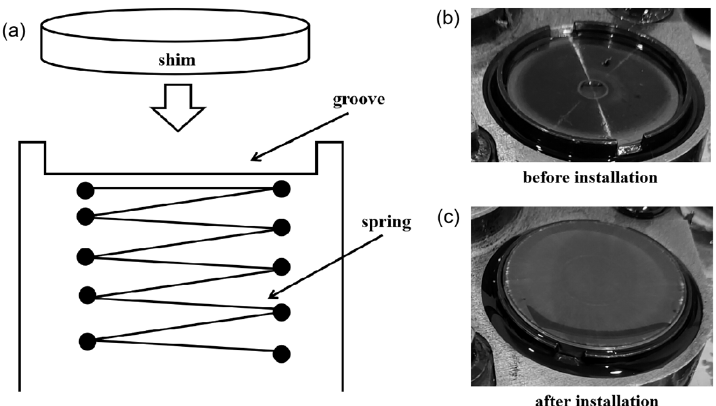
Figure 2. The circular shim installation: ( a ) installation diagram, ( b ) before installation; ( c ) after installation.